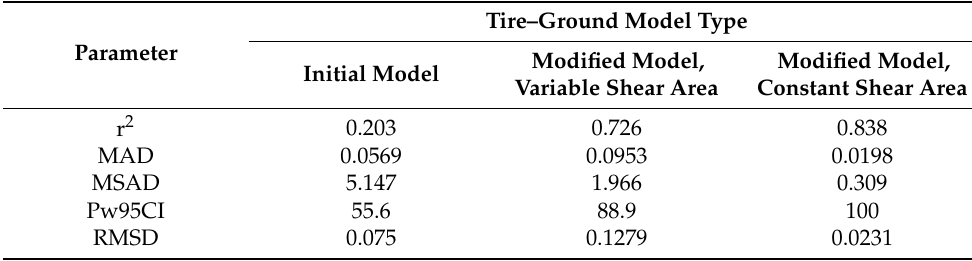
Table 5. Goodness-of-fit analysis: traction efficiency of the 2 WD tractor with 65 HP.